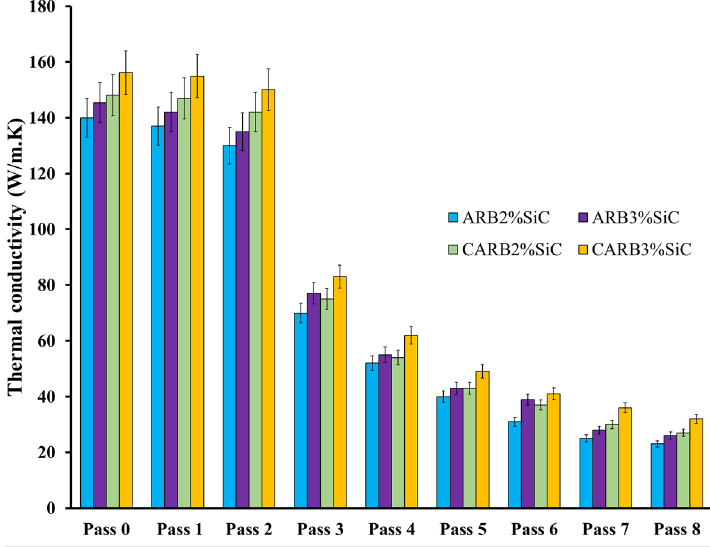
Figure 12. Thermal conductivity of composites at different passes.